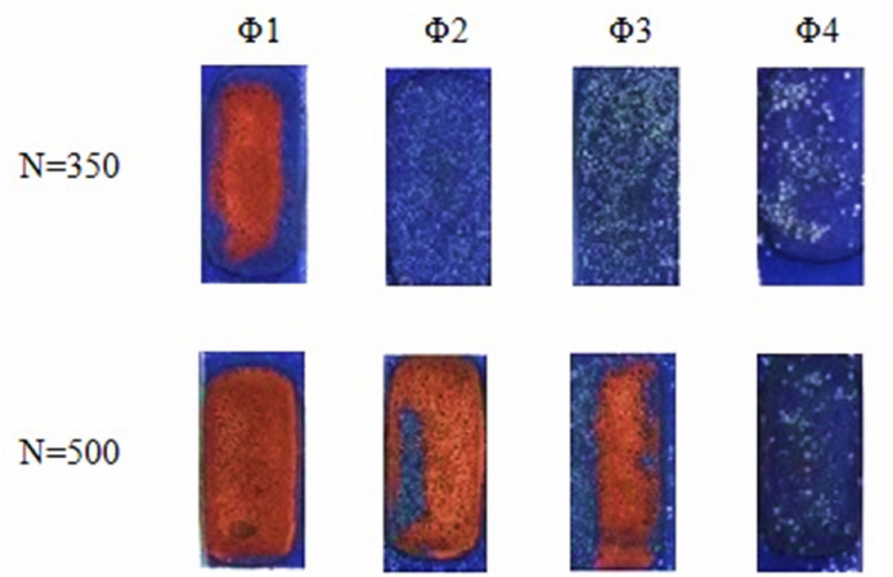
Figure 3. Coatings containing 15 wt.% of [Cu(L-tyr) 2 ] n and 5 wt.% of glass microspheres Φ 1 , Φ 2 , Φ 3 and Φ 4 , irradiated with 350 or 500 laser pulses (N) with a fluence of 100 mJ/cm 2 , after electroless metallization.